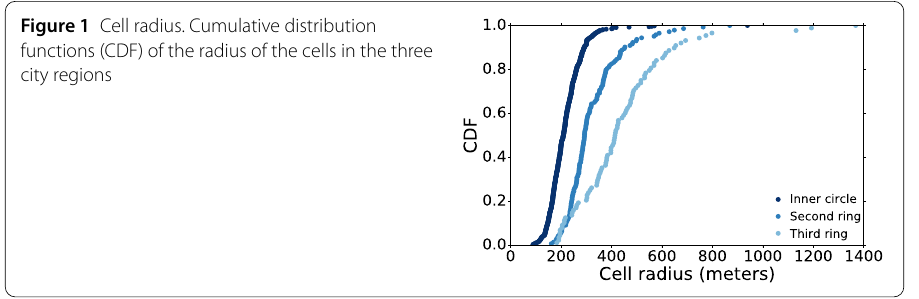
Figure 1 Cell radius. Cumulative distribution functions (CDF) of the radius of the cells in the three city